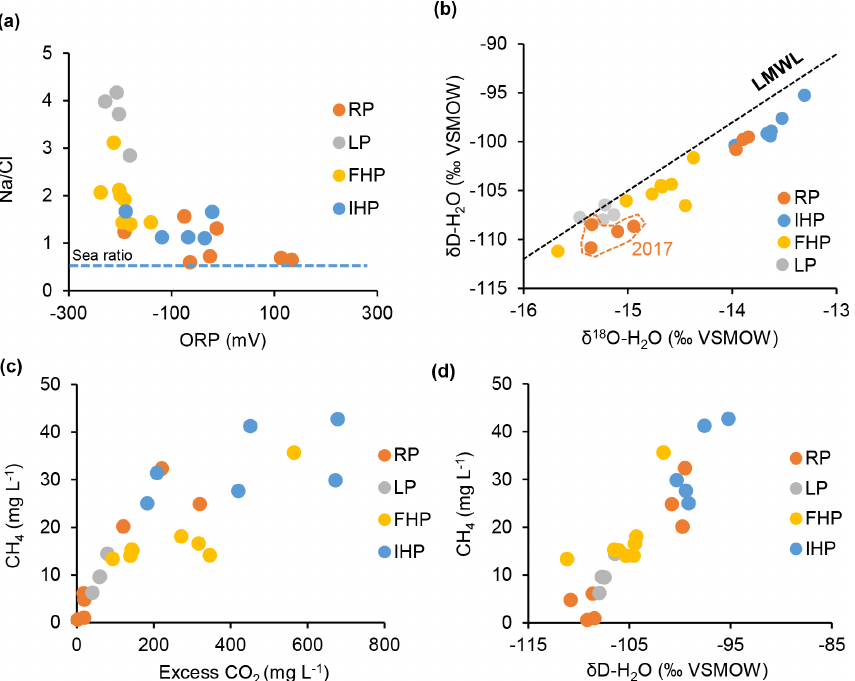
Figure 3. Key geochemical and dissolved gas characteristics in spring waters draining Riverbed Pingo (RP), Innerhytte Pingo (IHP), Første- hytte Pingo (FHP) and Lagoon Pingo (LP). “LMWL” denotes the local meteoric water line. The legend in (a) applies also to (b) – (d)